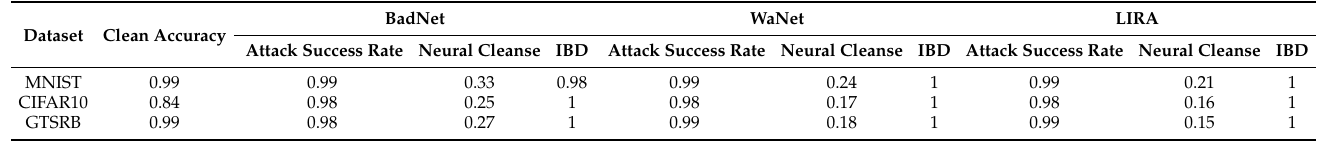
Table 2. Performance comparison of IBD and Neural Cleanse against three different backdoor-attack methods on three datasets. The clean detection accuracy and the attack detection accuracy represent the mean detection accuracy of 100 benign models and 100 poisoned models, respectively. The detection accuracy of IBD and Neural Cleanse is calculated on 200 models where the false positive rate is set to be 0% ( i.e., all the clean models are classified